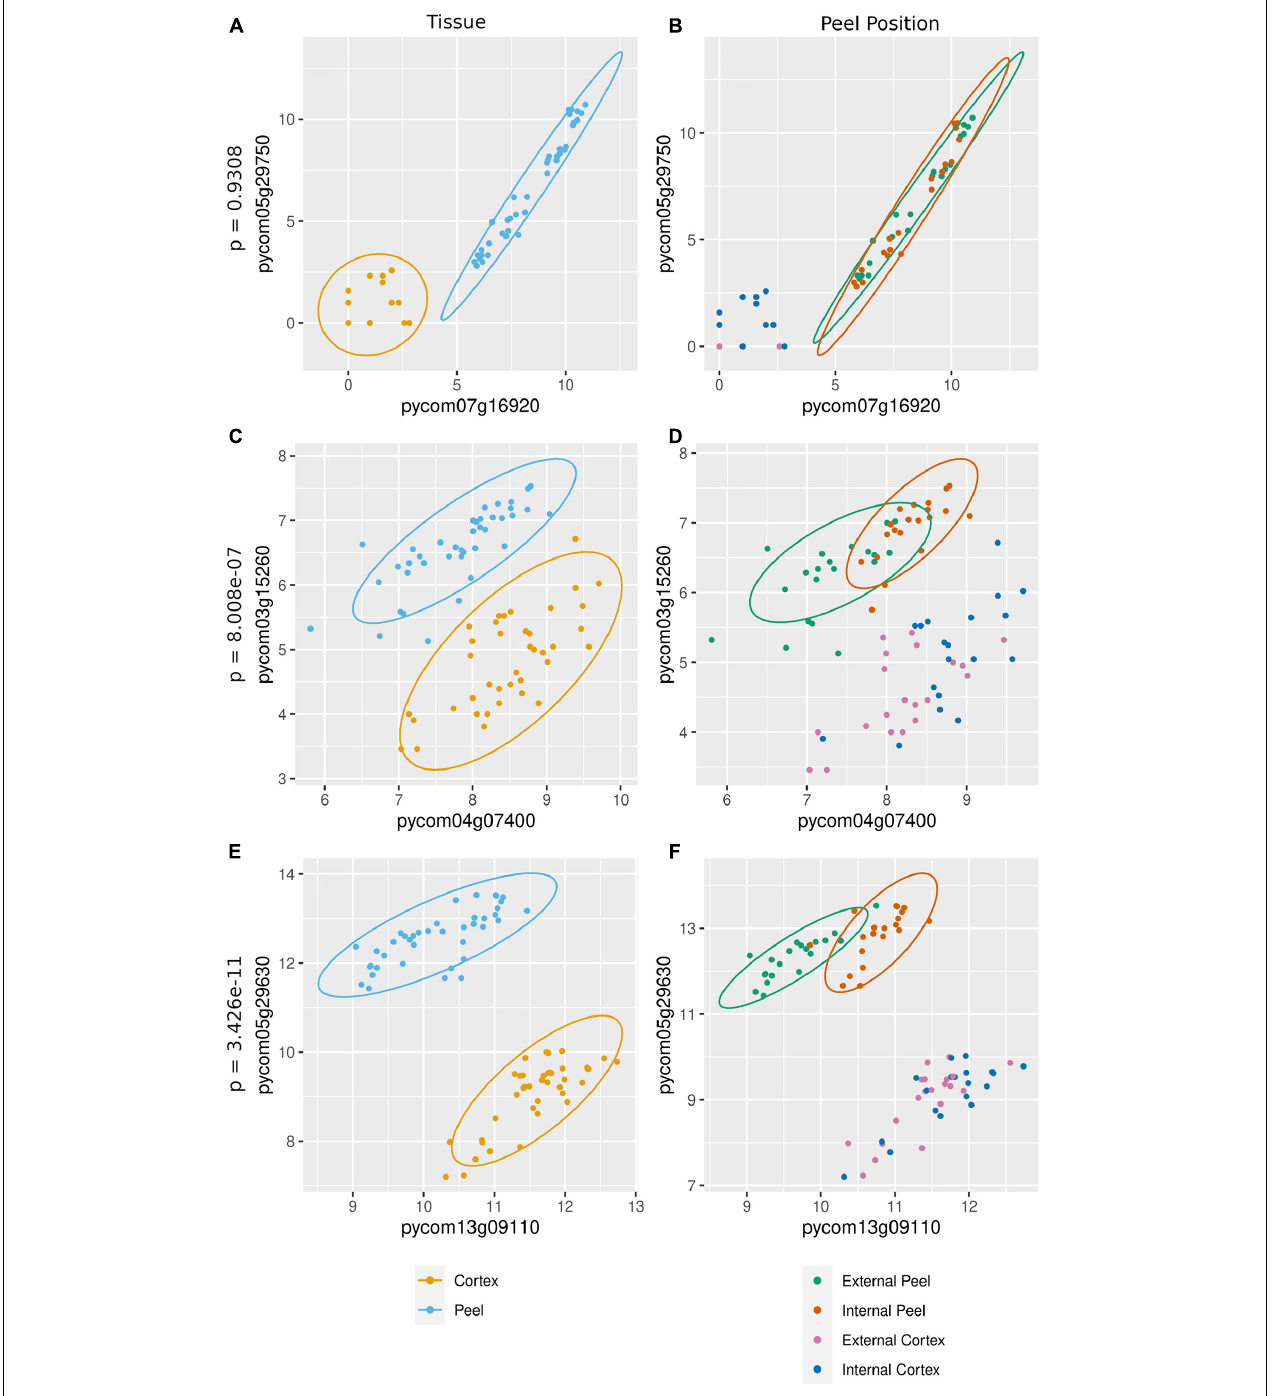
FIGURE 5 | Gene expression in canopy specific samples can show significantly different means, indicative of phased co-expression. (A,C,E) – examples of co-expressed genes (i.e., an edge detected by KINC) – the orange cluster is for cortex expression, and the blue cluster is for peel expression. (B,D,F) – tests for phasing in peel clusters (green for external peel, red for internal peel) that shows no difference in means between canopy positions (B) , and two examples of significant difference in means by canopy position (D,F) . Our sorting scheme created contrasts of fruit quality and ripening, derived from at-harvest differences in maturity. Phased gene expression patterns mirror the phased maturity we imposed on fruit harvest by sorting fruit by canopy position, suggesting that phased (i.e., differentially co-expressed) genes are involved in ripening.